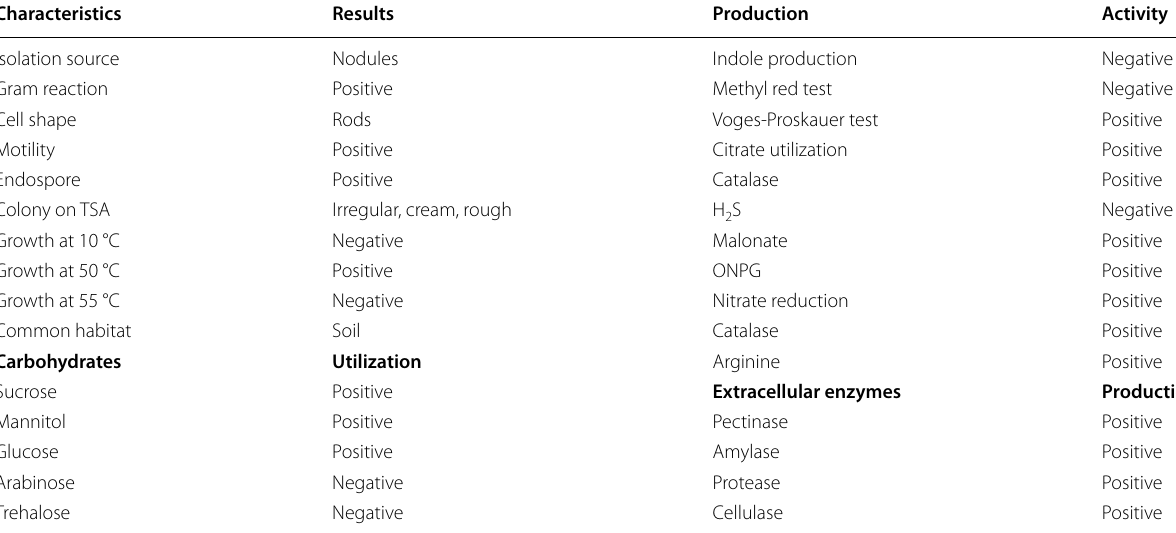
Table 2 Physiological and biochemical characteristics of MHN12